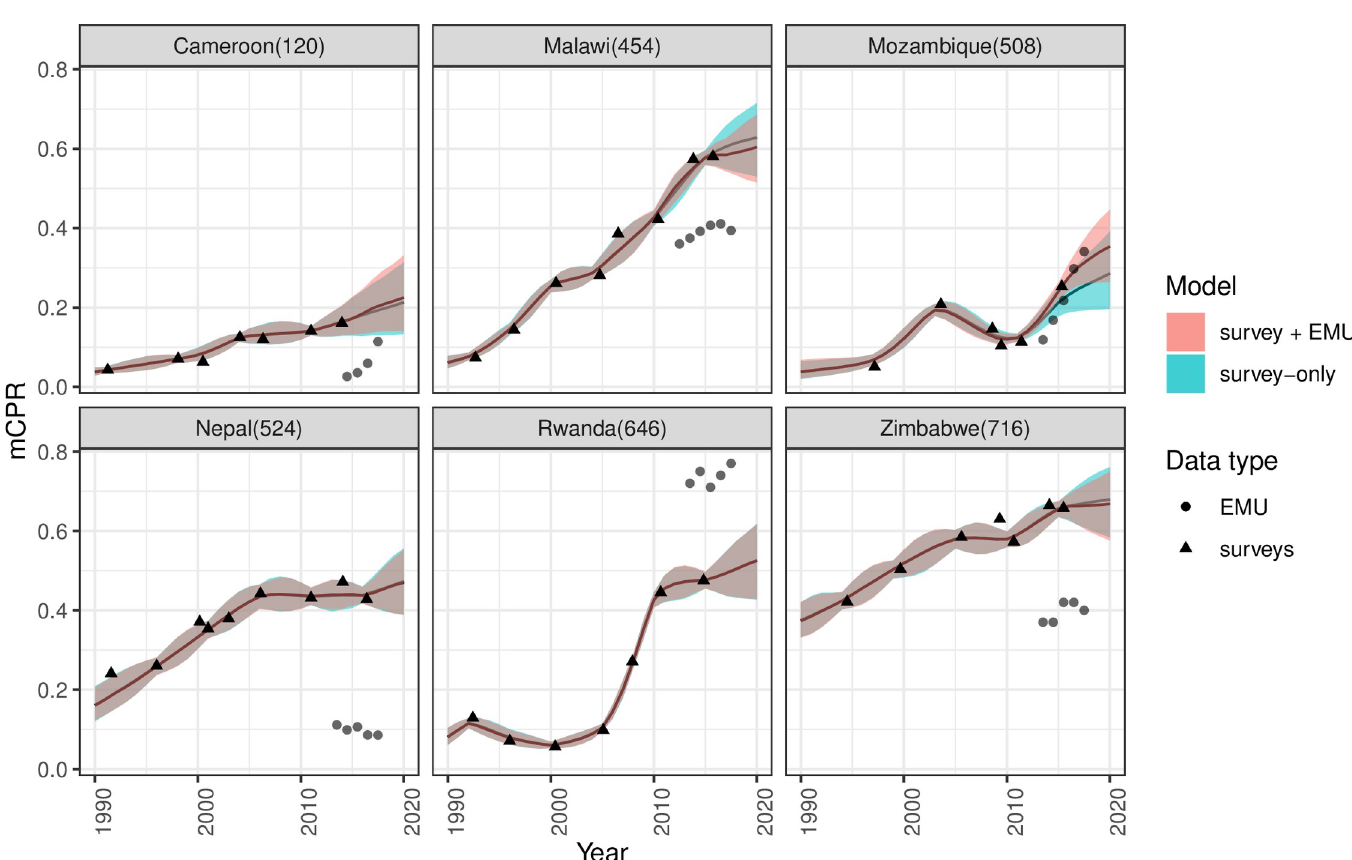
Fig 4. Comparing estimates and projections of mCPR. Solid lines indicate point estimates of mCPR and the shaded regions show the 95% uncertainty intervals. The results in green are from the EMU + survey model and the results in red are from the survey-only model. Shapes of data points distinguish survey observations from EMU.